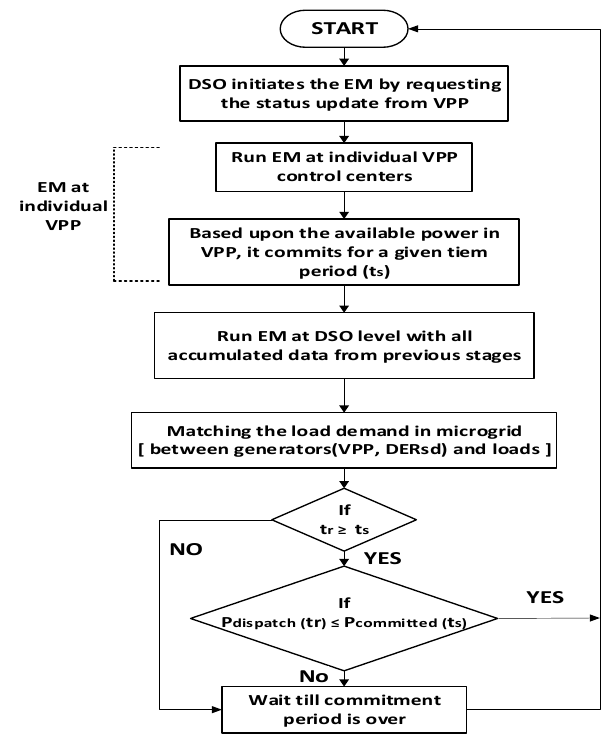
Figure 1. Flow chart of energy management (EM) involved in distribution system operator (DSO) and virtual power plant (VPP).